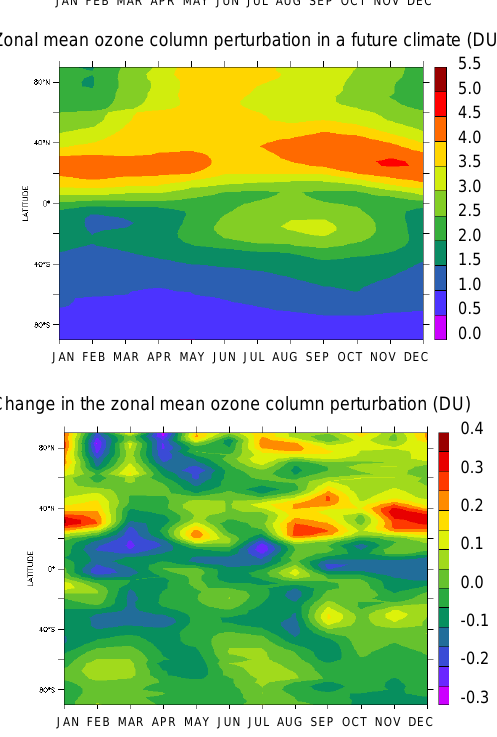
Fig. 12. Impact of transport emissions on the zonal mean tropo- spheric ozone column (a) in a present and (b) in a future (A1B sce- nario, 2050) climate, and (c) corresponding change ( 1